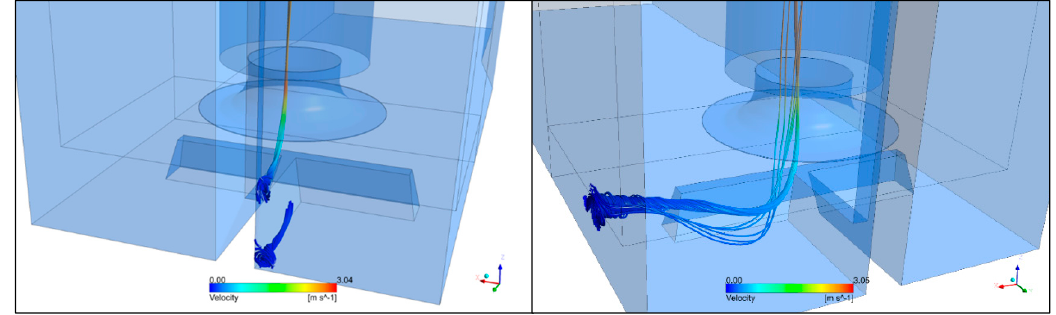
Figure 19. Sidewall and backwall vortices observed on numerical results.